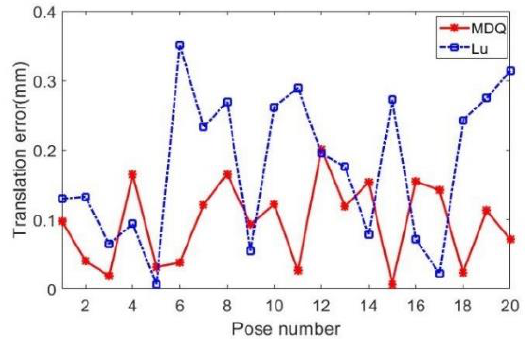
Figure 4. The RMS errors in translation interfered with random noise.